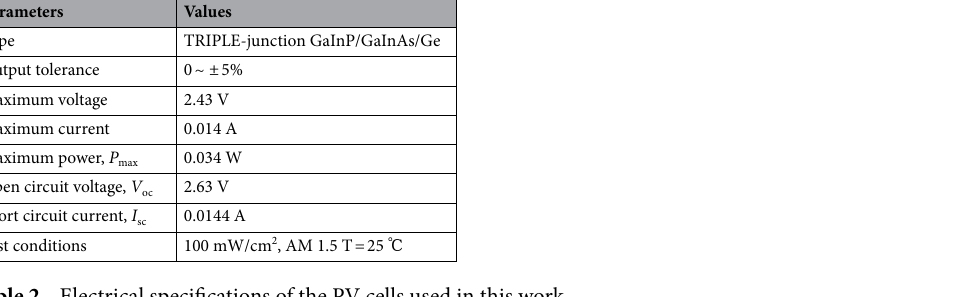
Table 2. Electrical specifications of the PV cells used in this